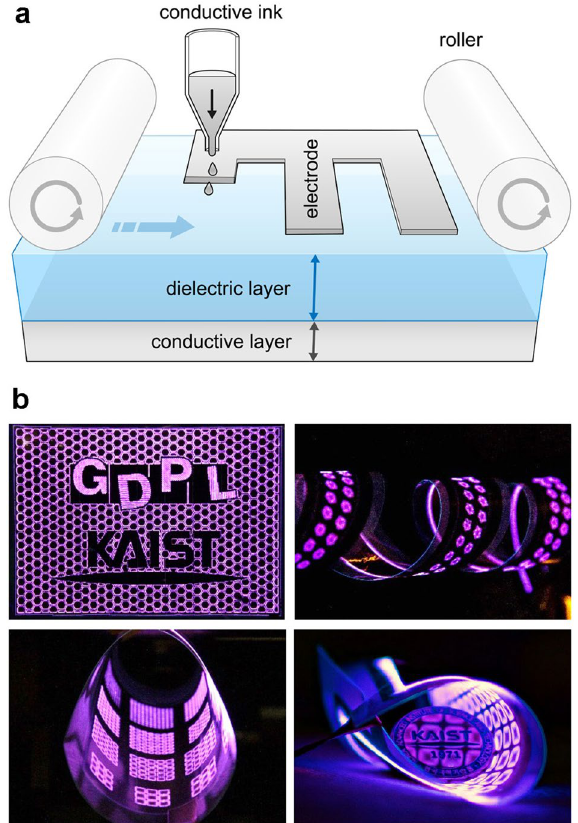
Figure 1. ( a ) Schematic illustration of inkjet printing used to form a thin-film electrode on a flexible dielectric barrier discharge source. The cross-sectional view of the FXDBD source shows two conductive layers and a dielectric barrier film (PET). ( b ) Examples of FXDBD with different inkjet-printed, patterned electrodes operated in ambient air to demonstrate the flexibility of electrode formation (i.e., a large variety of electrode shapes and sizes) and the flexibility of the